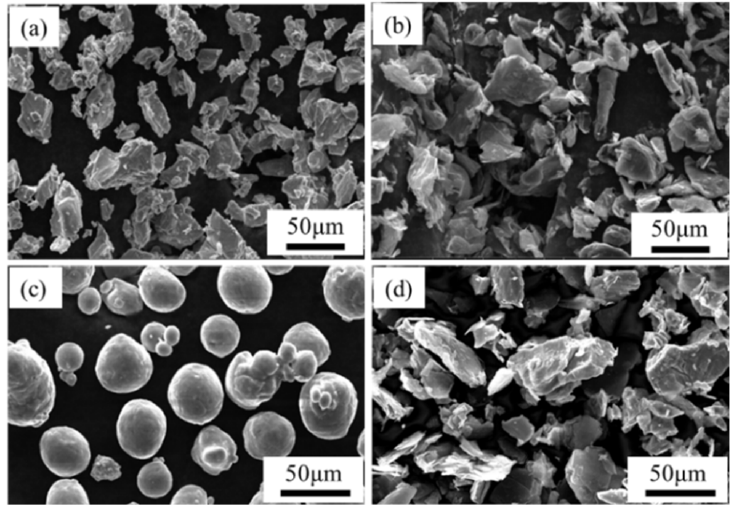
Figure 1. Morphology of raw materials: ( a ) Ti powder, ( b ) graphite powder, ( c ) Al powder, ( d ) Nb powder.